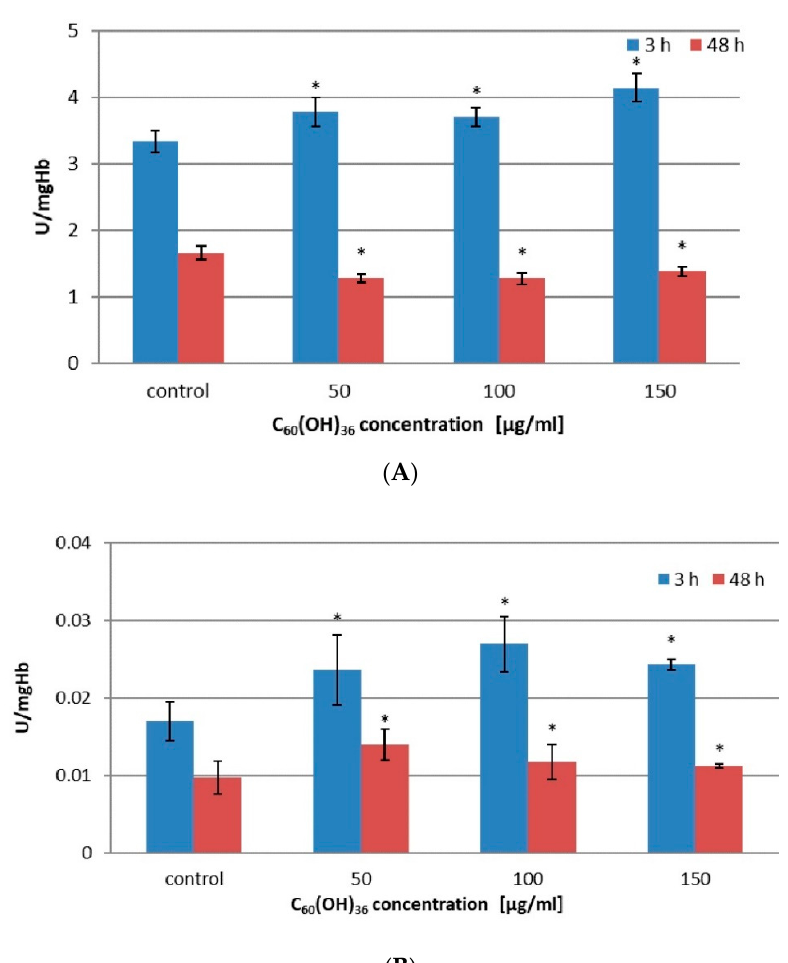
Figure 1. The effect of C 60 (OH) 36 on the activity of catalase ( A ) and glutathione peroxidase ( B ) converted to 1 mg of hemoglobin protein. Measurements were made after 3 and 48 h of incubation of erythrocytes with C 60 (OH) 36 at concentrations of 0, 50, 100, and 150 μ g/mL at 37 °C. The bars represent the mean values ± SD for 3 independent measurements. * Statistically significant values in relation to controls after 3 h and 48 h incubation at p < 0.05.